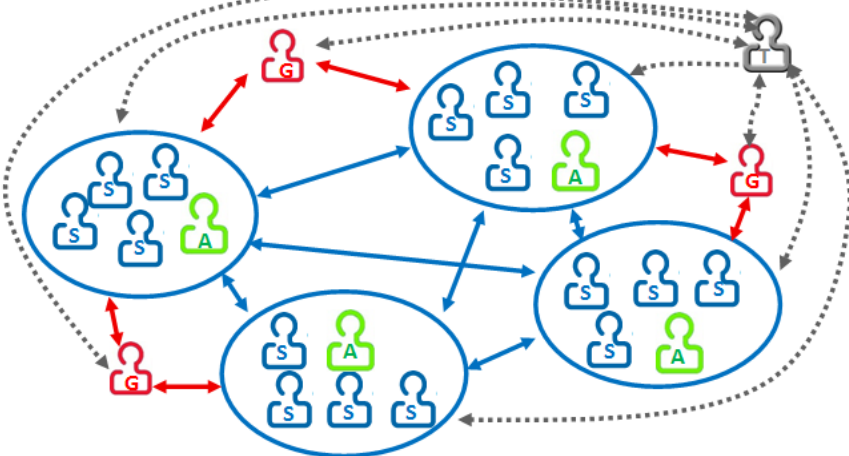
Figure 2. A new four-grade organization structure model of learning